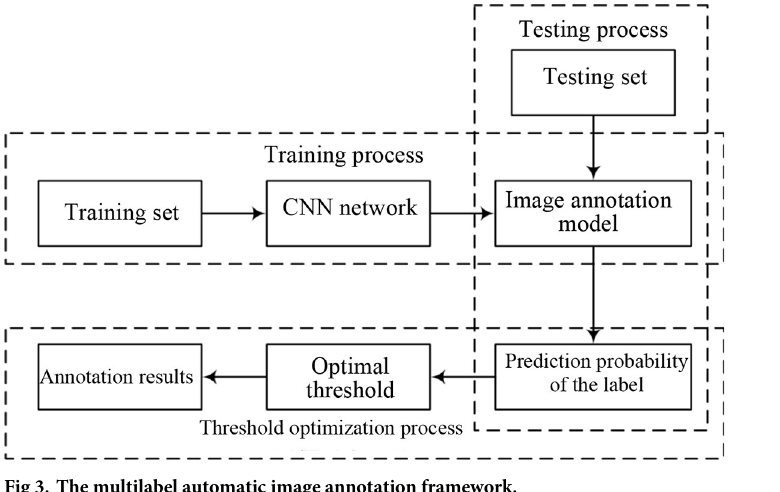
Fig 3. The multilabel automatic image annotation framework.